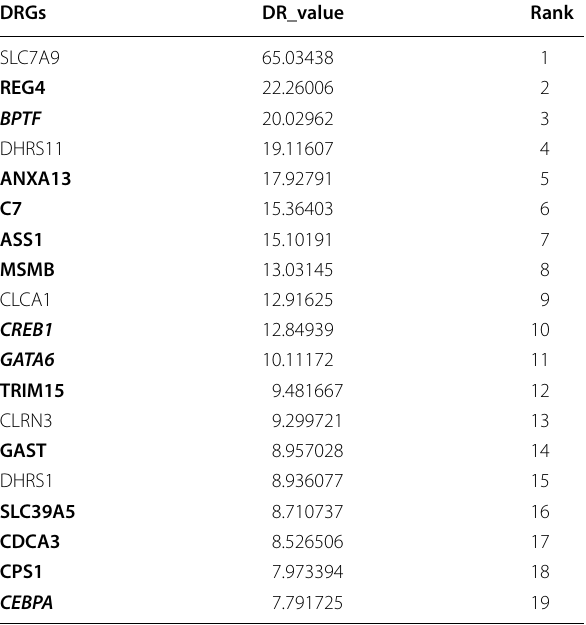
Table 3 The top 1% genes in DRG list